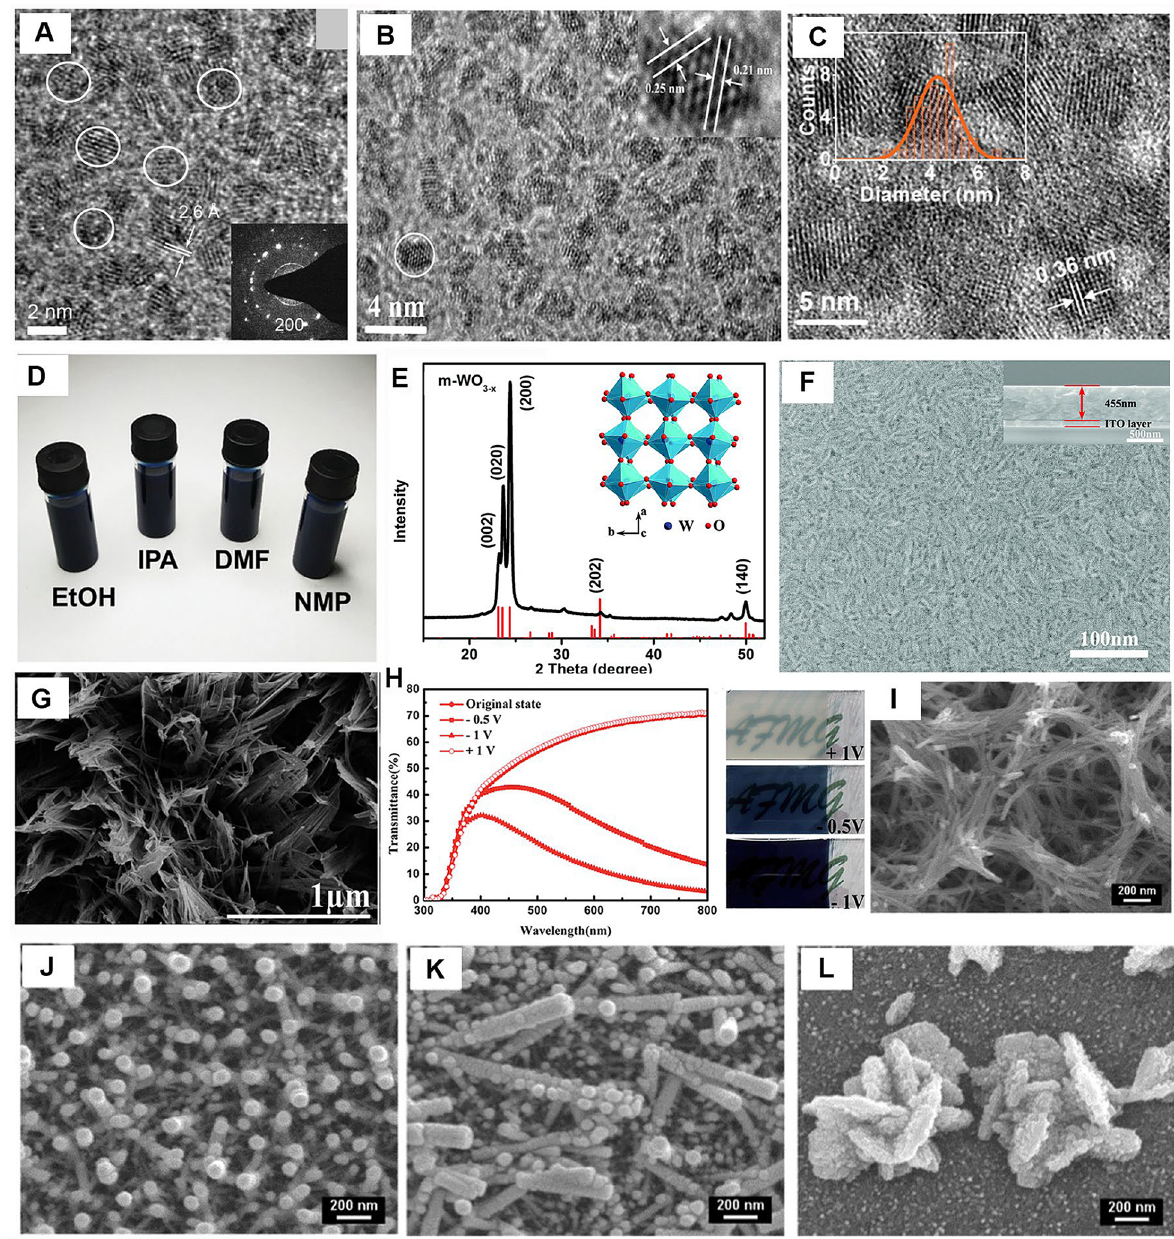
Figure 8: Structure and characterization of WO 3 -based electrochromic fi lms. (A) Transmission electron microscopy (TEM) image of tungsten oxide quantum dots (QDs) with average sizes of 1.6 nm. Reproduced with permission from Ref. [151]. Copyright 2014, Wiley. (B) High-resolution TEM image of as-prepared tungsten oxide QDs. Reproduced with permission from Ref. [152]. Copyright 2020, Elsevier. (C) TEM image of WO 3 − x nanocrystals. Inset shows the nanocrystals diameter statistics. (D)WO 3 − x inksbasedonfourdifferentsolvents.(C – D)ReproducedwithpermissionfromRef.[146].Copyright2020,Wiley.(E)XRDpatternsand crystal structure (inset) of m-WO 3 − x NWs. (F) Surface and cross-sectional (inset) SEM images of m-WO 3 − x NW fi lms. (E – F) Reproduced with permission from Ref. [47]. Copyright 2018, Royal Society of Chemistry. (G) Scanning electron microscope (SEM) image of self-seeded grown WO 3 ·0.33H 2 Oelectrodewithlessamountofethyleneglycol.(H)Opticaltransmittancespectraandphotographsoftheself-seededgrownWO 3 · 0.33H 2 O fi lm measured at different biases. (G – H) Reproduced with permission from Ref. [153]. Copyright 2014, Royal Society of Chemistry. FESEM images of WO 3 fi lms doped with different Ni content: (I) 0%, (J) 0.5%, (K) 1.5% and (L) 2.5%. (I – L) Reproduced with permission from Ref. [56]. Copyright 2016, Royal Society of